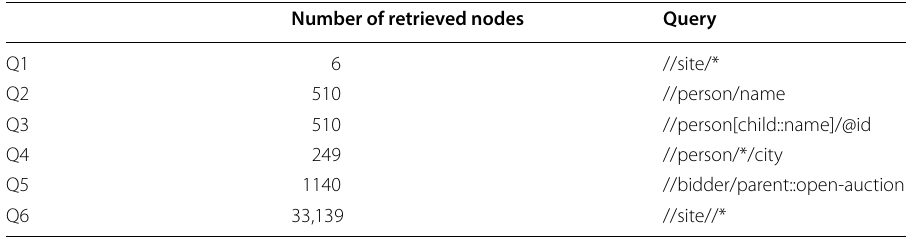
Table 3 Evaluated